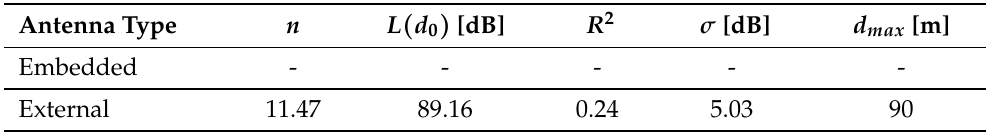
Table 11. Path loss regression coefficients and statistical results for Non-Line-of-Sight scenario (two